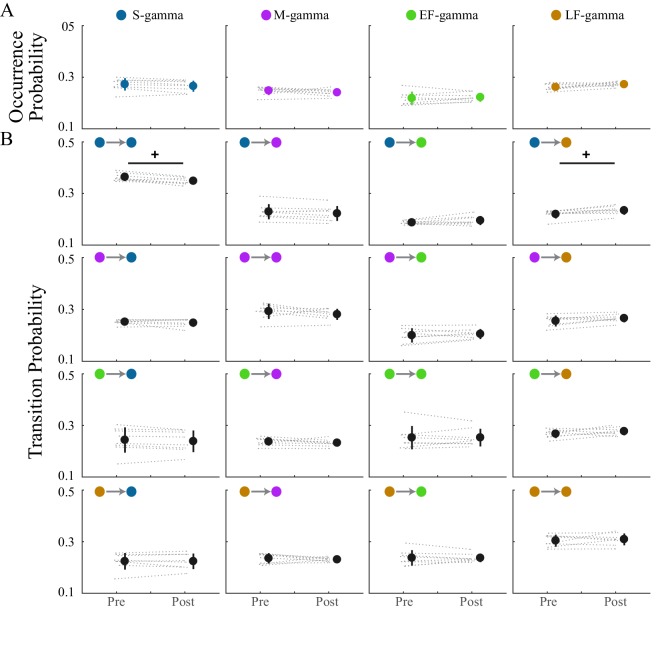
Transition matrix and occurrence of the four TG states during REM.(A) TG state occurrence of the four states are presented in four graphs; comparisons are made across sessions. Note that in total 20 = [4 × 4 (transition matrix) + 4 (occurrence)] × 1 (pairs of session) comparisons are made (paired t test). (B) A 4 × 4 graph display shows the transition probability from the current state (row) to the next state (column); in each individual graph, the transition probabilities are compared across two experimental sessions (pre-maze period and post-maze period). + denotes significant difference, FDR correction for 20 comparisons (q < 0.1).